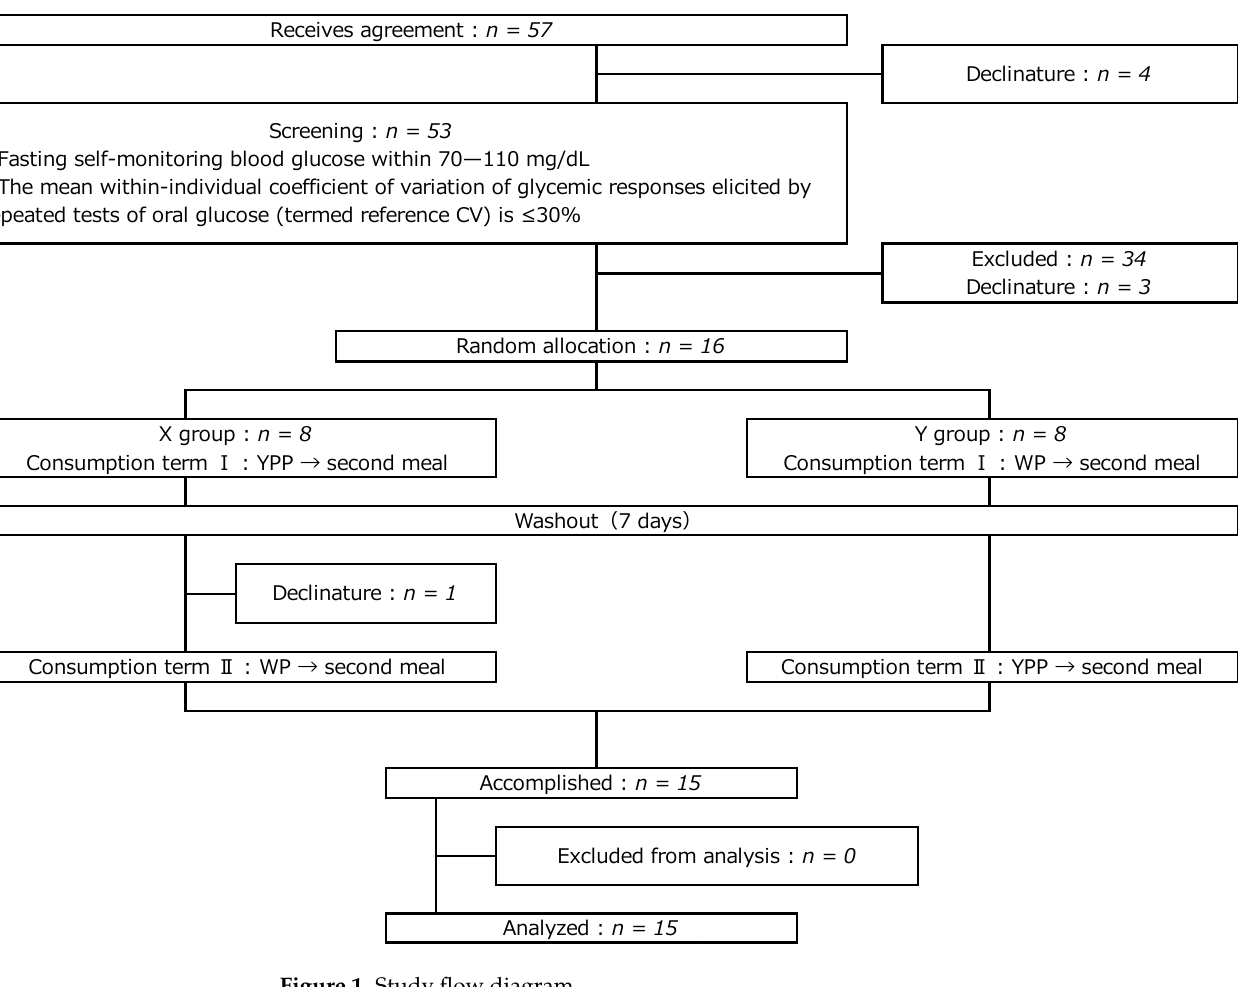
Figure 1. Study flow diagram.